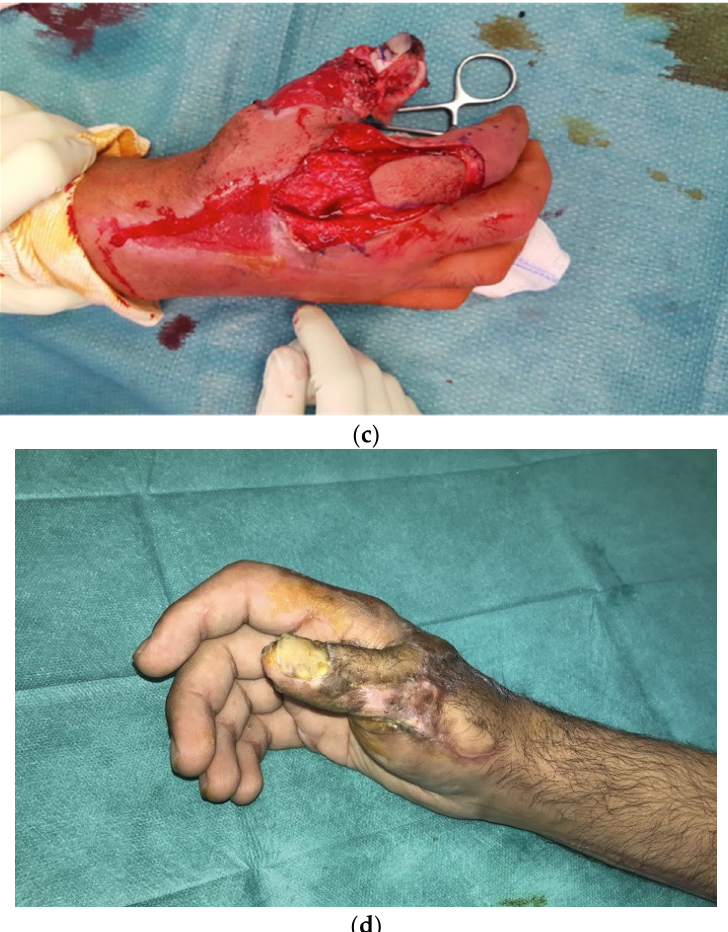
Figure 2. A 27-year-old patient presented with the clinical signs of necrotizing fasciitis of the right hand following an injury involving a wrought-iron handle 48 h earlier ( a ). Exploration of the vascular pedicles of the right thumb had revealed contracted vessels surrounded by infected tissue; a precautionary debridement was performed to preserve the vascular pedicles ( b ). The necrotic areas and all the non-viable tissue of the right thumb were debrided, with excision of the long extensor tendon of the thumb. The IP joint was opened, revealing the presence of pus; the cartilage was then resected until healthy, vascularized bone was reached. Following liberal irrigation of the articulation and tissues using Betadine ® , we ensured arthrodesis of the thumb IP joint with two pins using X-ray guidance. To cover the loss of soft tissue on the dorsal side of the thumb, leaving the IP joint exposed, it was decided to perform a kite-shaped dorsal metacarpal artery flap. The flap was drawn on the dorsal side of the first phalange of the second finger, going from the extension fold of the PIP, up to the metacarpophalangeal joint and laterally to the mediolateral line ( c ). The flap donor site and the flap pedicle were covered by a full-thickness skin graft removed from the inner surface of the right arm. Six months later, the result was satisfactory, with good functional recovery and articular mobility ( d ).